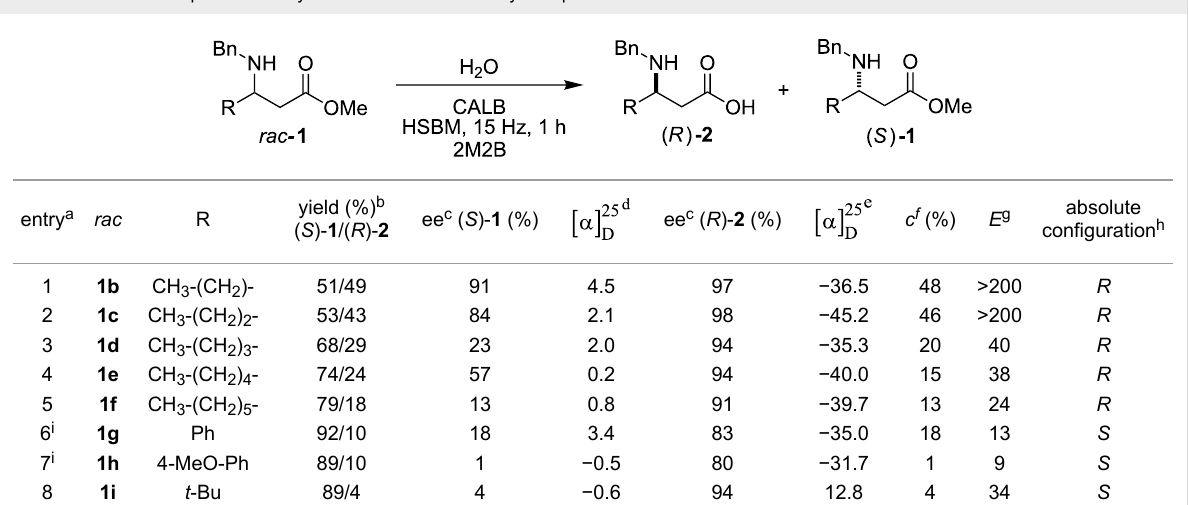
Table 2: Substrate scope for the enzymatic resolution of N -benzylated- β 3 -amino esters.